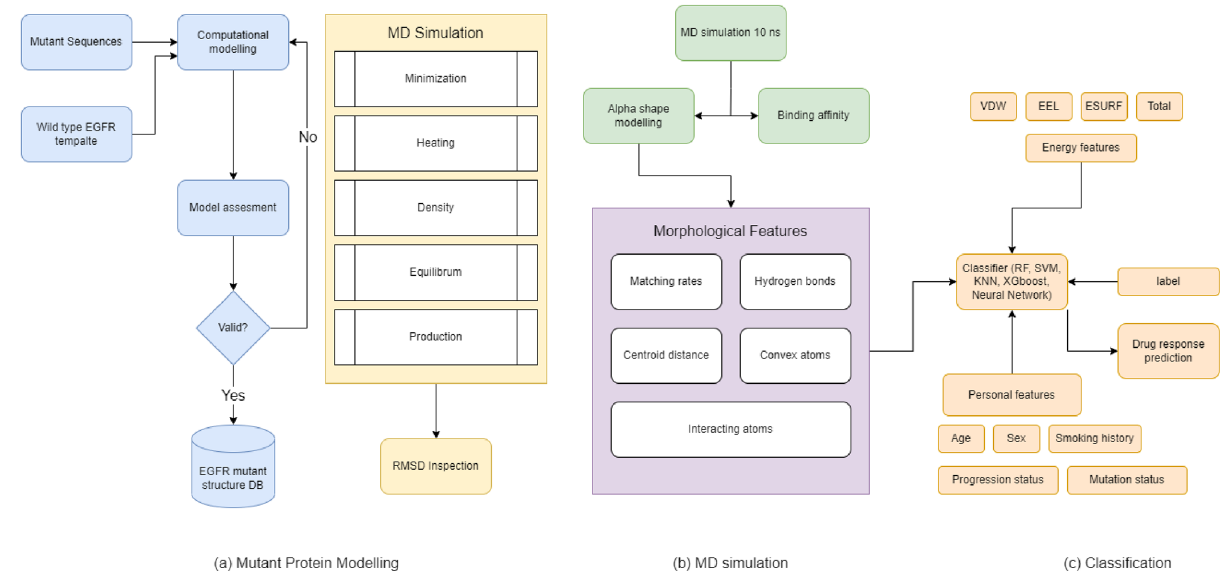
Figure 10. The framework for predicting the drug response in lung cancer patients based on personal data, binding energy, and geometric features. Mutant structures are predicted by computational methods then molecular dynamics simulations extract energy and geometrical features. Machine learning classifiers then predict four classes of drug response from these Figure 10b and c show the steps of the MD simulation and the formulation of the classification models. Each mutation was modeled in the 3D structure of the protein-drug complex. Our dataset consisted of 33 different EGFR point mutations. For each mutant, MD simulations were performed and the binding free energy was calculated. Multiple machine learning models were used to predict the response level. Dataset collection. All the methods under this study were performed in accordance with the relevant guidelines and regulations of City University of Hong Kong (CityU). Informed consent was taken from all par- ticipants.The experimental protocols were approved by the Institutional Review Board (IRB) of City University of Hong Kong. The clinical information used in this study was collected from several published sources 13,26,32–34 . A dataset of 201 NSCLC patients was obtained and 140 samples were used to train the model. 61 independent samples were used to test the model, with 3, 5, 36, and 17 samples for stable disease, no response, partial response and complete response respectively. The L858R mutation was the most frequent mutation, followed by second- ary point mutation L858R-T790M and delE746-750, as shown in Fig. 3b. The EGFR mutations were selected based on a survey in 42 .